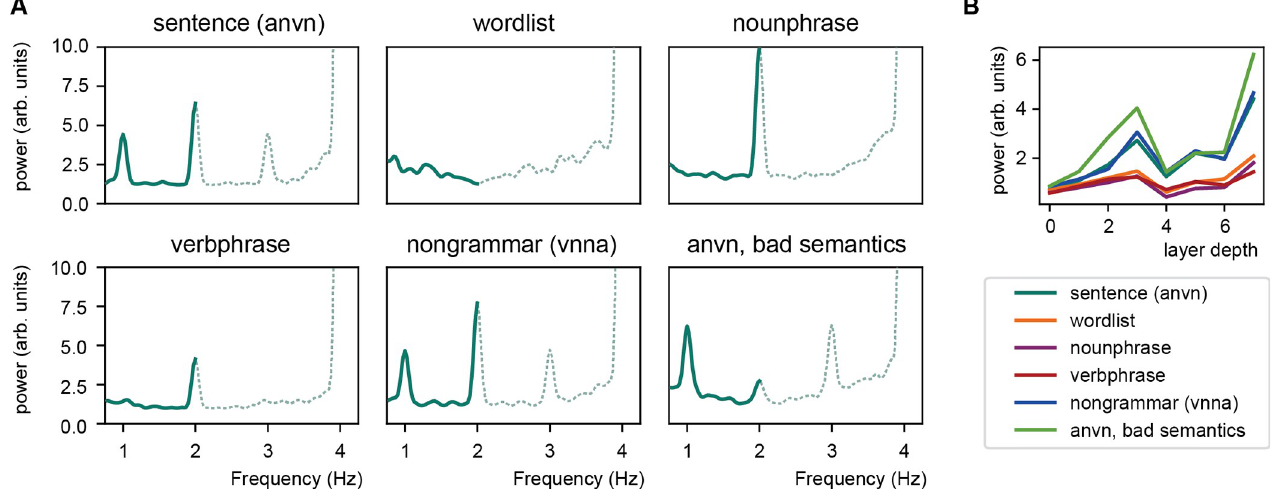
Fig 1. Output of the Berkeley parser. (A) Spectra of the output of the parser using different versions of the Ding and colleagues stimuli (a = adjective, n = noun, v = verb). Dashed lines indicate output from the FFT when interpolating the data by inserting zeros after every word (up-sampling the data from 4 to 8 Hz). (B) 1-Hz response across the different layers of the parser